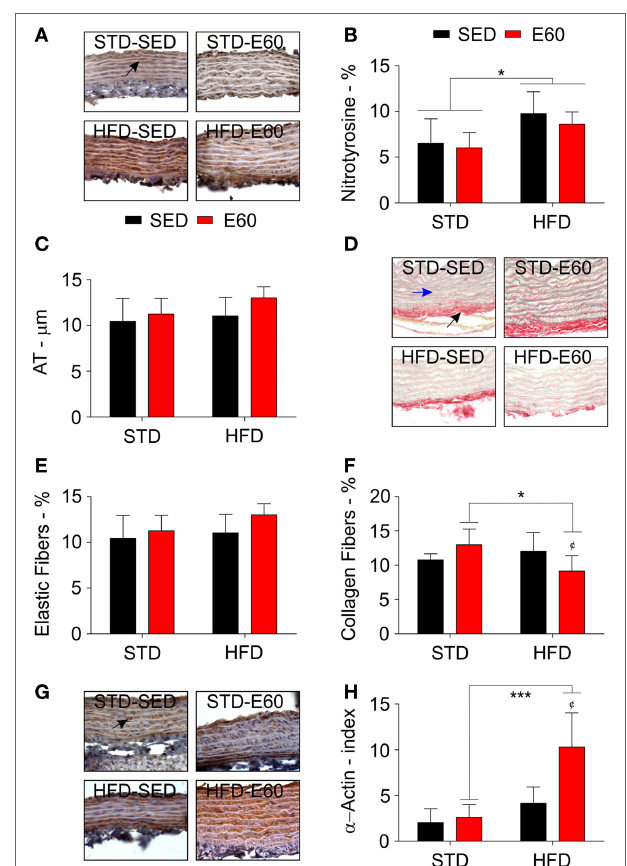
FigUre 1 | a high-fat diet (hFD) damages the aorta aside from protective effects of physical training . (a) Representative pictures illustrate reactions with an anti-nitrotyrosine antibody for each experimental group in aorta samples. A black arrow shows a positively stained cell with that anti-nitrotyrosine antibody. Sedentary rats were given a regular chow [standard diet (STD)-SED]; exercised rats were fed a regular chow (STD-E60); sedentary rats were given an HFD (HFD-SED); and, exercised were rats fed an HFD (HFD-E60). (B) A histopathological analysis determined nitrotyrosine values (%) by optical density. (c) A microscopic analysis determined atrial thickness (micrometers) in aortic slices stained with hematoxylin and eosin. (D) Representative pictures illustrate picrosirius red staining for each experimental group in aorta samples. A black arrow shows red-stained collagen fibers. A blue arrow shows yellow stained elastic fibers. (D,e) A histopathological analysis determined the density of elastic (e) and collagen fibers (F) . (g) Representative pictures illustrate reactions with an anti- α -actin antibody for each experimental group in aorta samples. A black arrow shows a positively stained cell with that anti- α -actin antibody. (h) A microscopic analysis determined the number of positive α -actin cells per area (millimeter; index). Statistical Analysis I: ¢ p < 0.05 vs. HFD-SED. Statistical Analysis II: * p < 0.05 and *** p < 0.001. Data analysis: two-way ANOVA test (Bonferroni’s post hoc test). Reported values are the mean ± SD.